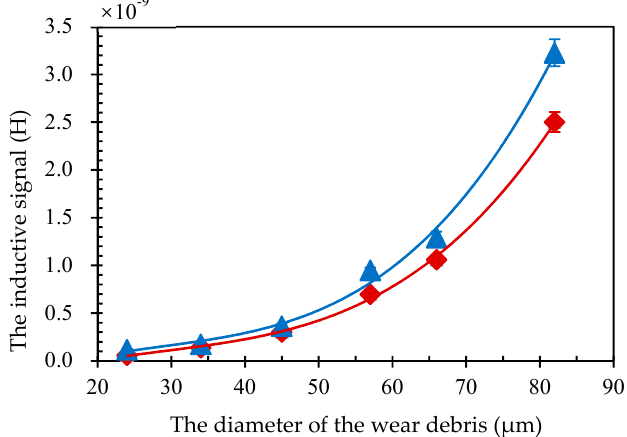
Figure 4. The variation of inductive signal of wear debris with different size for coil with 60% magnetic powder (blue triangle dot) and without (red diamond dot). The solid line is the fitting line of the experimental data.